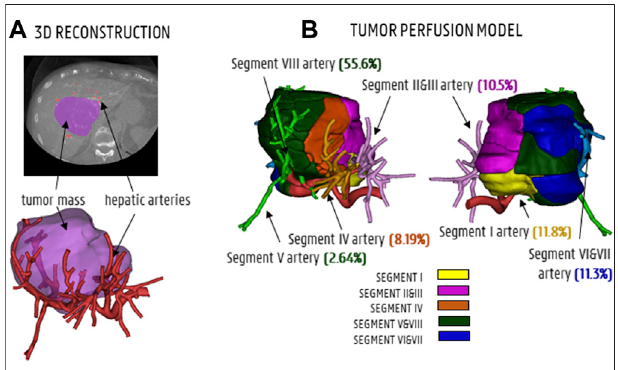
FIGURE 1 | (A) CT-scan slice and 3D reconstruction showing the tumor mass(purple)andhepatic arteries(red). (B) Thetumorperfusionmodelshows to which degree the segmental arteries I, II and III, IV, V and VIII and VI and VII contribute to tumor perfusion (TPPs in